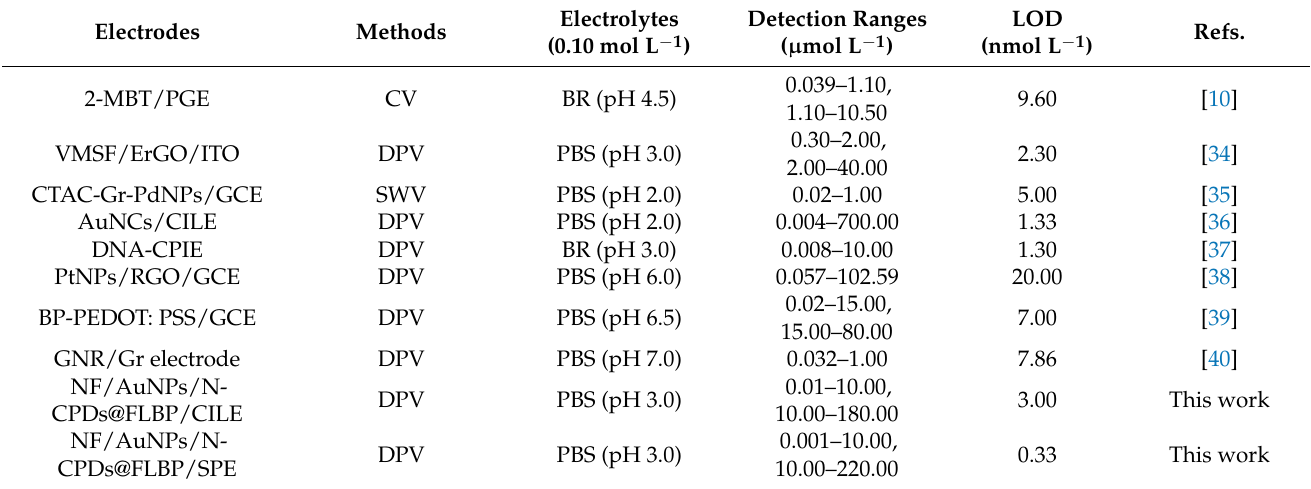
Table 1. Comparisons of the analytical performance of rutin detection with different modified